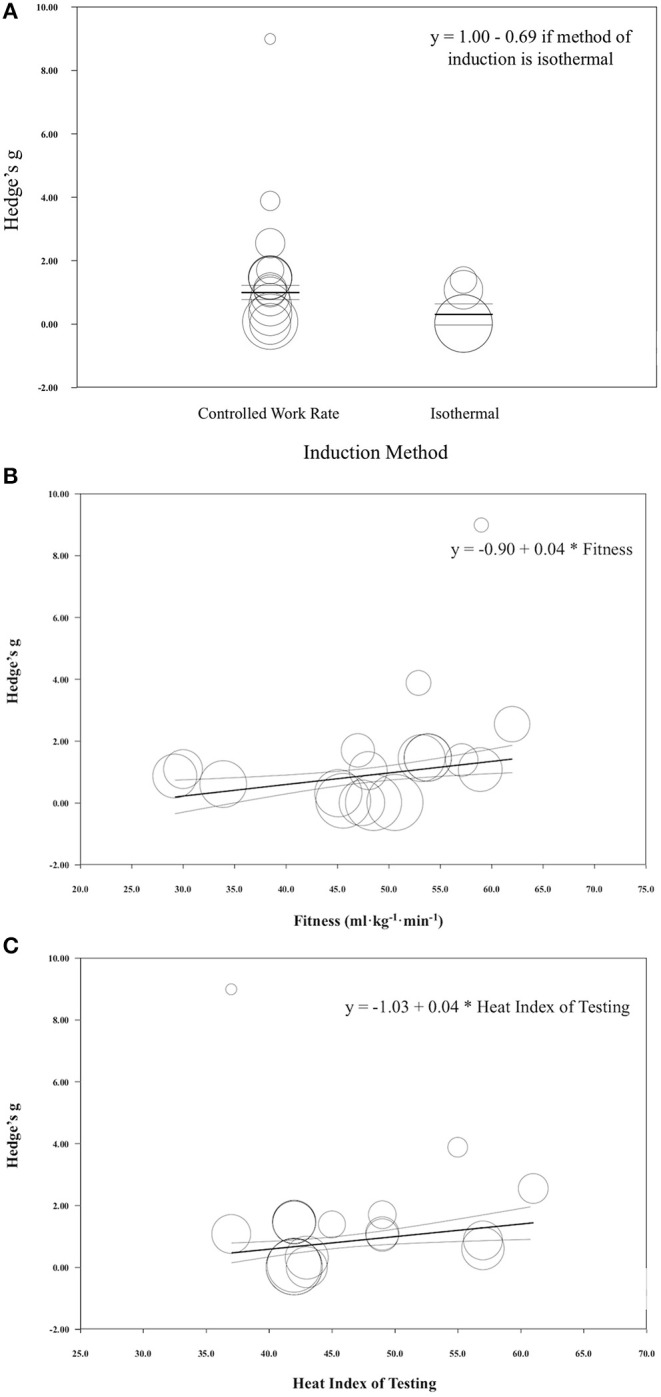
(A) Regression of Hedge's g on induction method for time to exhaustion exercise performance following heat acclimation. Solid black bars represent the mean Hedge's g. Each circle represents individual studies. The size of the circle represents the weight of that study that was applied in the analysis. Smaller circles indicate lower weight and larger circles indicate higher weight. (B) Regression of Hedge's g on fitness level for time to exhaustion exercise performance following heat acclimation. Solid black bars represent the mean Hedge's g. Each circle represents individual studies. The size of the circle represents the weight of that study that was applied in the analysis. Smaller circles indicate lower weight and larger circles indicate higher weight. (C) Regression of Hedge's g on heat index for time to exhaustion exercise performance following heat acclimation. Solid black bars represent the mean Hedge's g. Each circle represents individual studies. The size of the circle represents the weight of that study that was applied in the analysis. Smaller circles indicate lower weight and larger circles indicate higher weight.